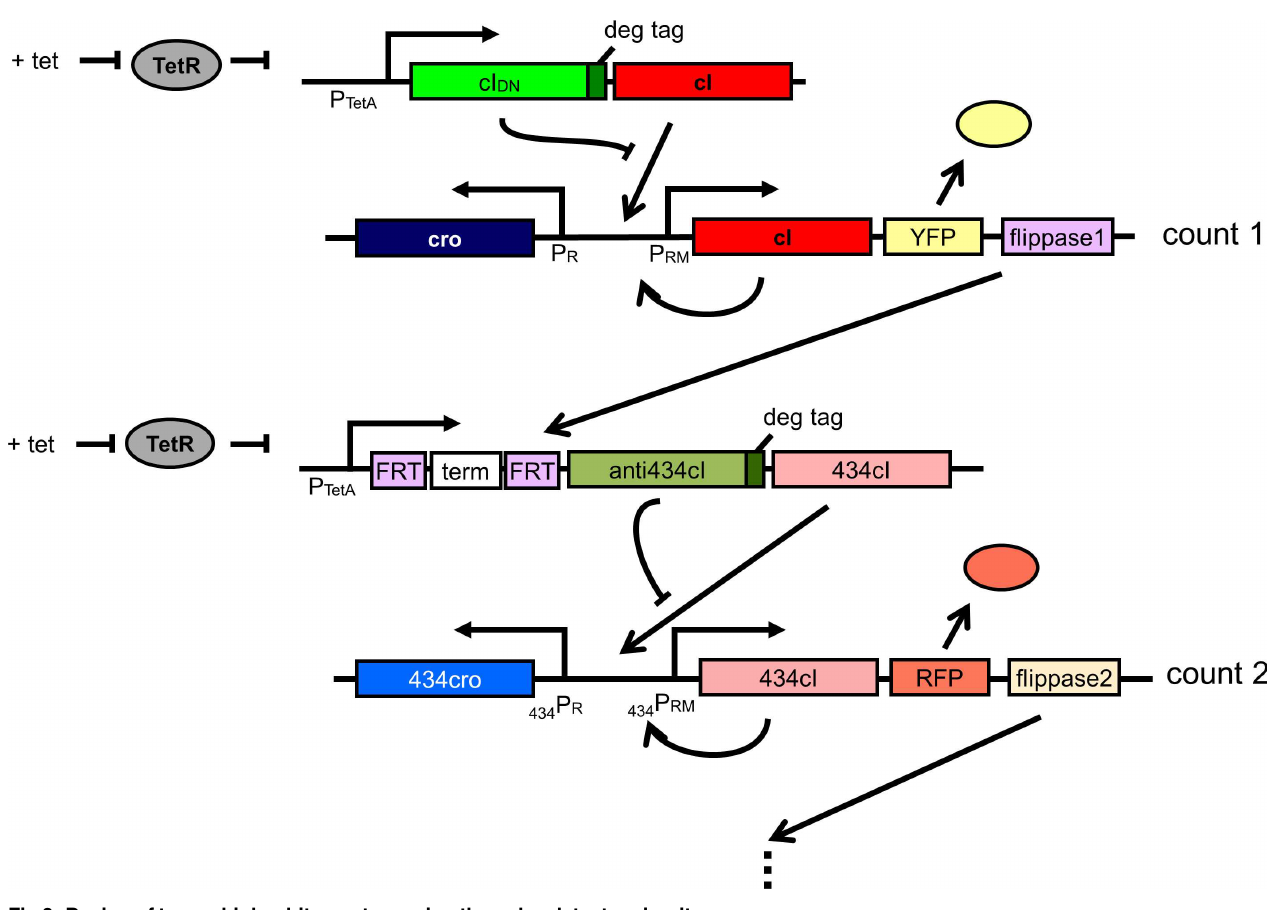
Fig 8. Design of two or higher bit counters using the pulse detector